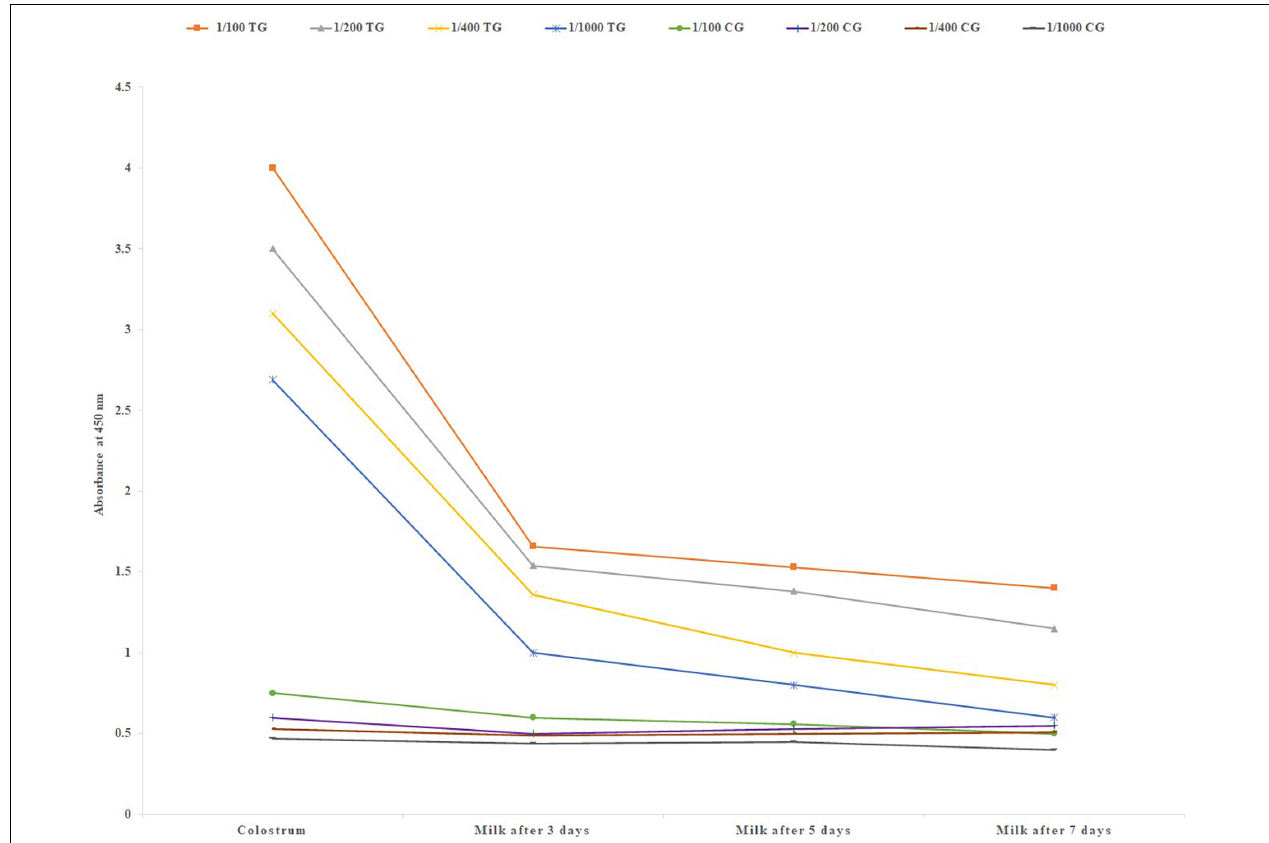
FIGURE 2 | Mean specific IgG level in different colostrum and milk dilutions of six treatment and three negative control pregnant cows after parturition, using in-direct ELISA test. TG, Treatment group; CG, Control